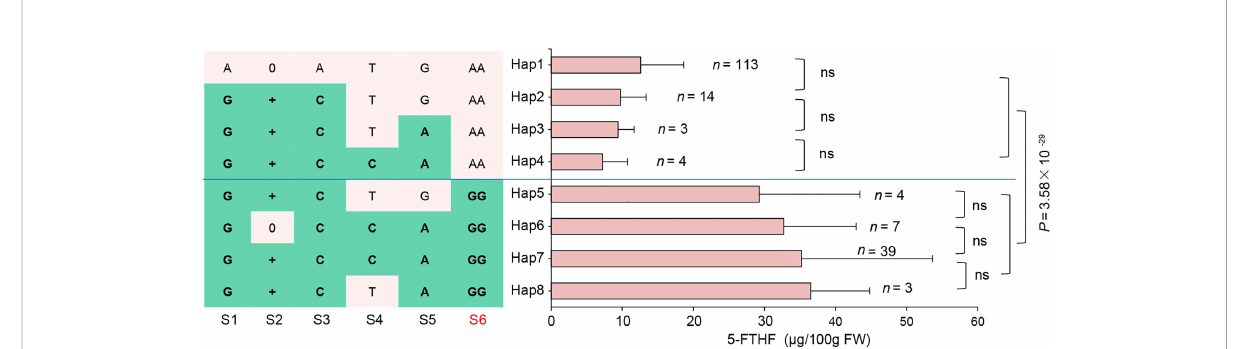
FIGURE 5 Haplotypes of ZmFCL among natural variations in sweet corn inbred lines. n denotes the number of genotypes belonging to each haplotype group. When a string of variations are in complete LD, only one is shown. S6 was the causative variant mentioned above. Statistical signi fi cance was determined by a two-sided t-test. ns denotes no signi fi cance between two